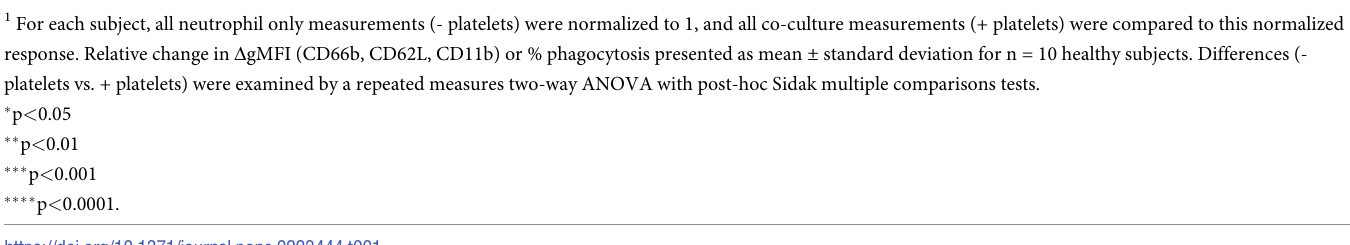
Table 1. Relative change in neutrophil markers measured by flow cytometry in neutrophil-platelet co-culture. Agonist ng/mL Unstimulated